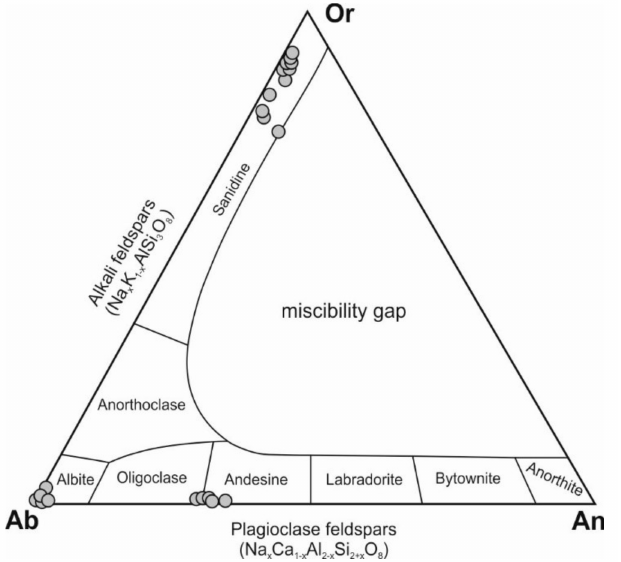
Figure 9. Ternary feldspar classification diagram shows the presence of K-felsdspar, albite and oligoclase-andesine endmember molecules indicating chlorite grains. Data given in